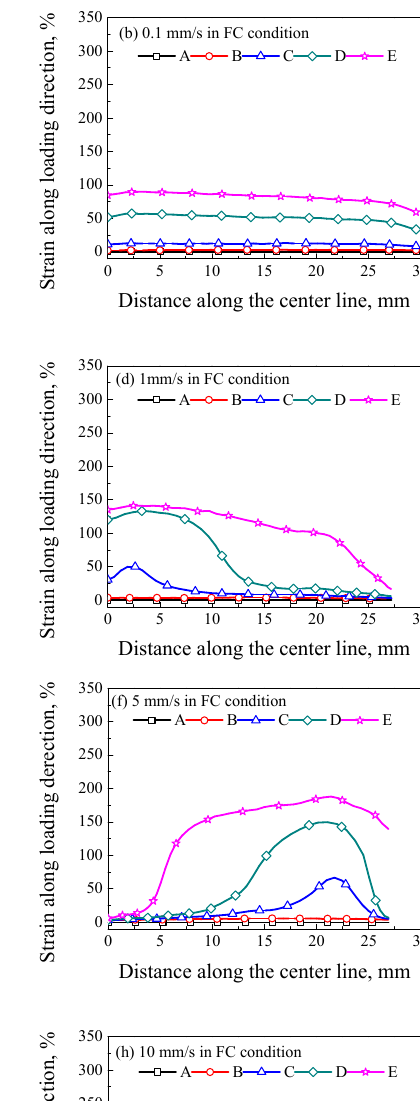
Figure 8. Curves of maximum temperature change and displacement at different loading rates in the NC and FC conditions.